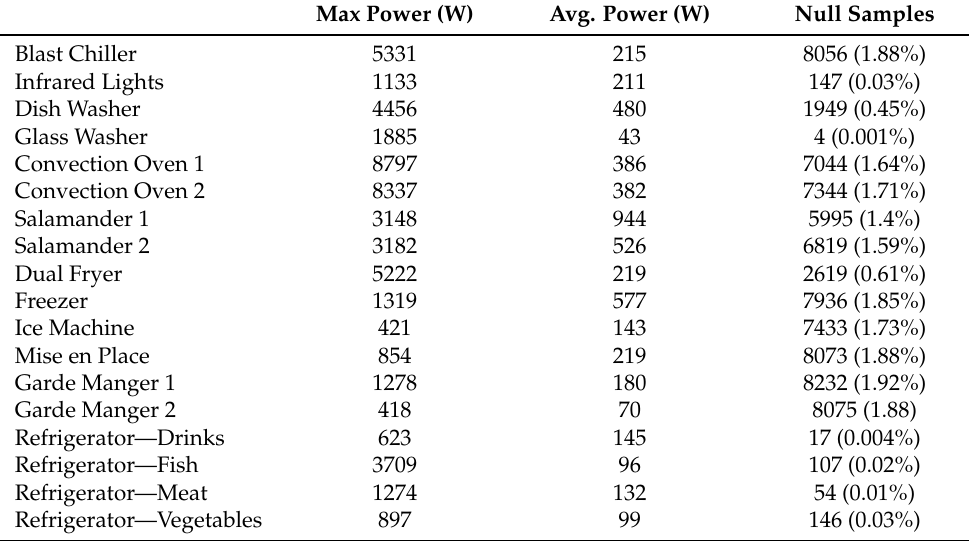
Table 1. Summary of the appliance-level data that constitute the